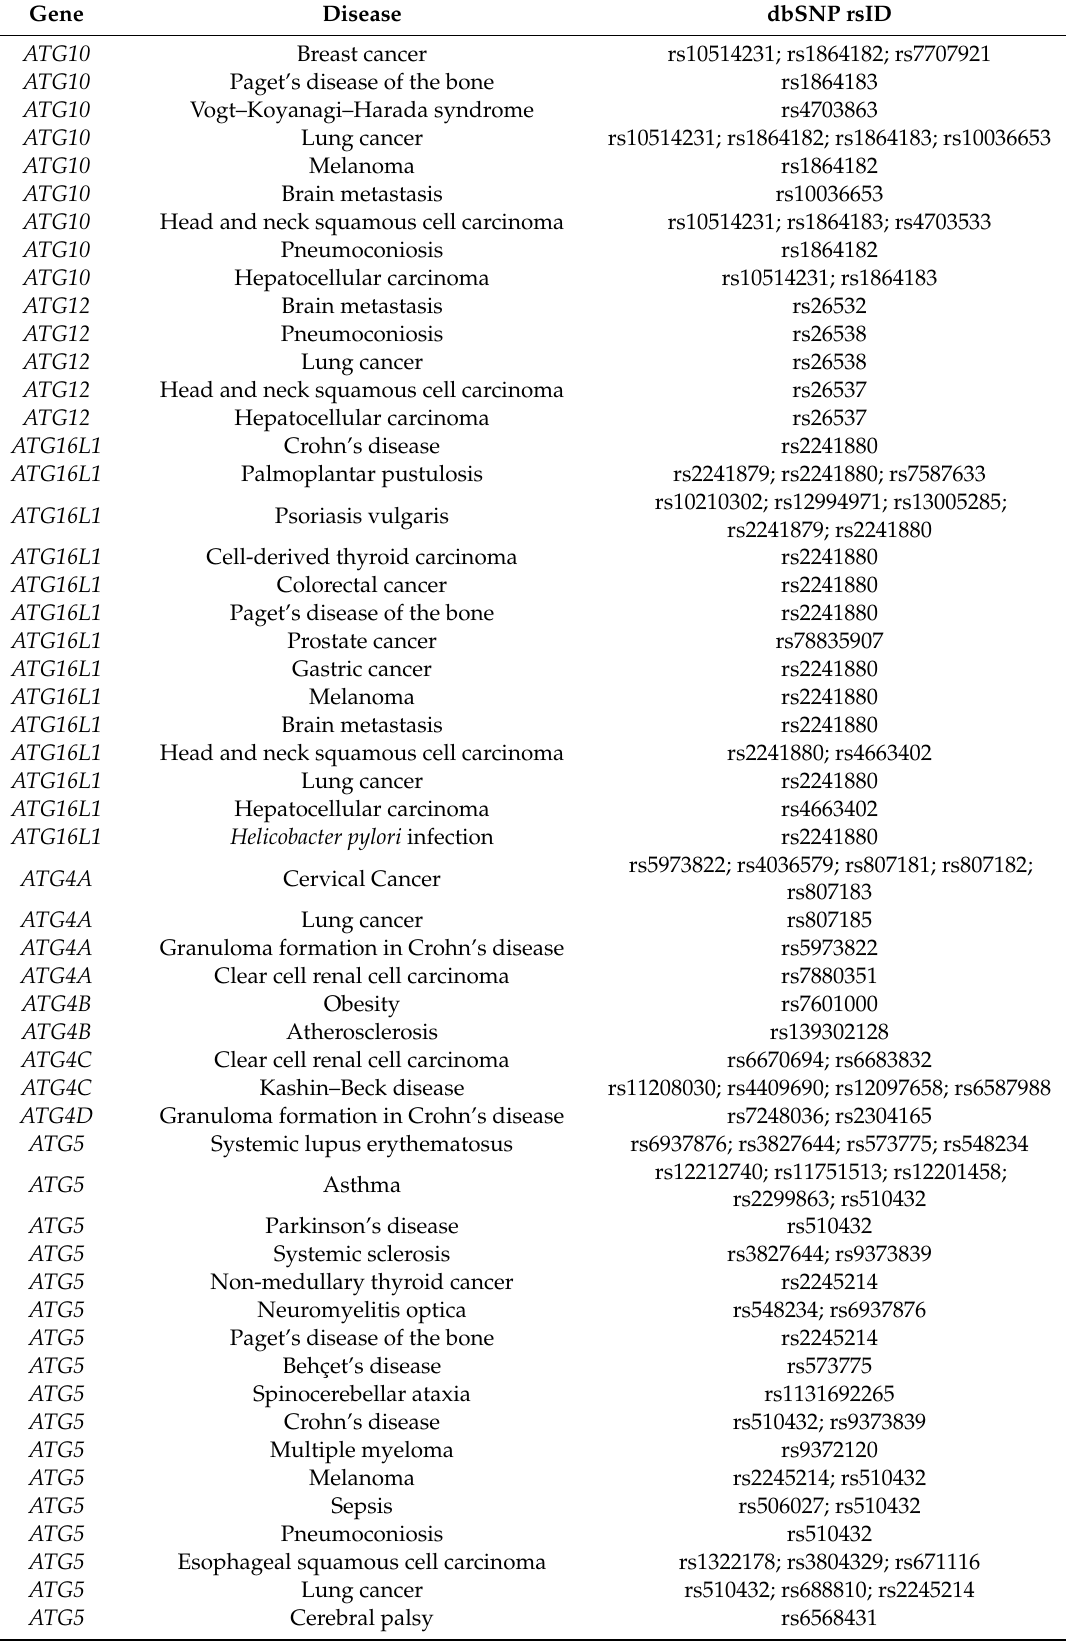
Table 4. Clinically relevant SNPs in the ubiquitin-like conjugation systems ATG12 and